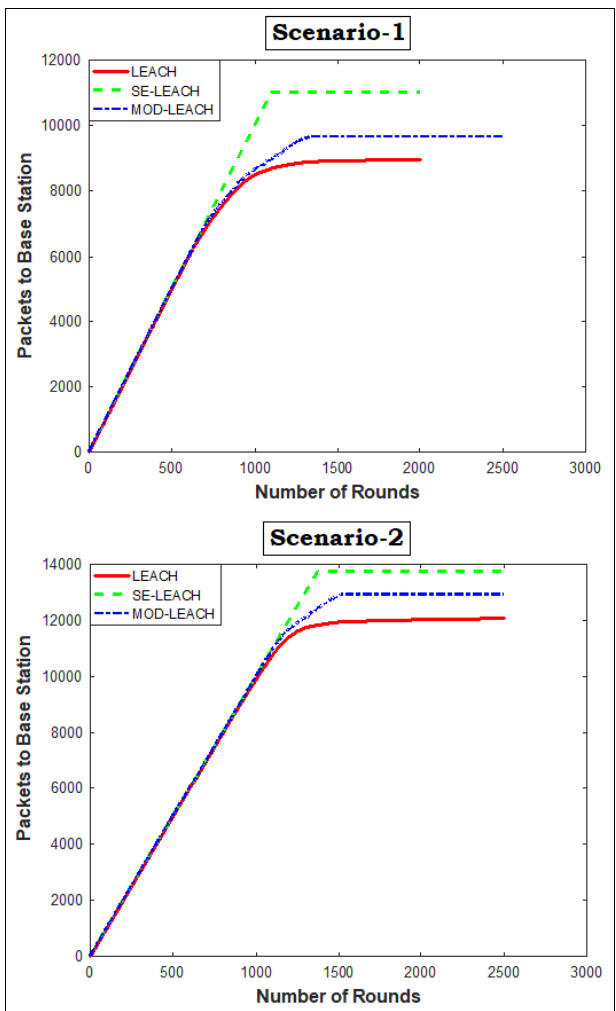
Figure 5. Network throughput